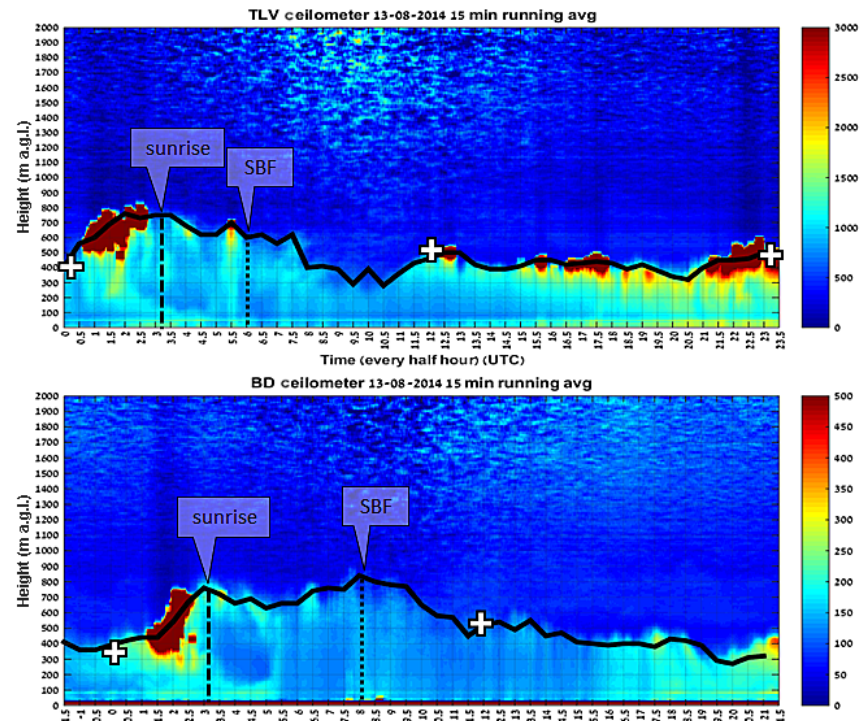
Figure 5. Same as Fig. 4 but for 13 August 2014.